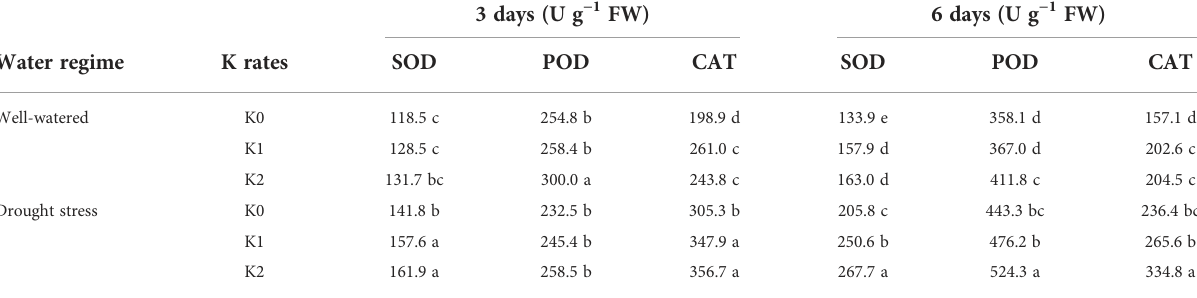
TABLE 1 Effects of drought stress on the activities of SOD, POD, and CAT in sesame leaves at the fl owering stage under different K levels.